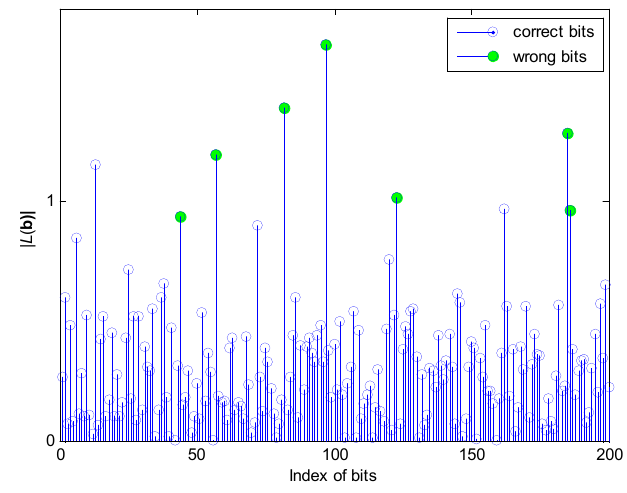
Figure 2. The value of differential characteristics function | L ( b k )|.